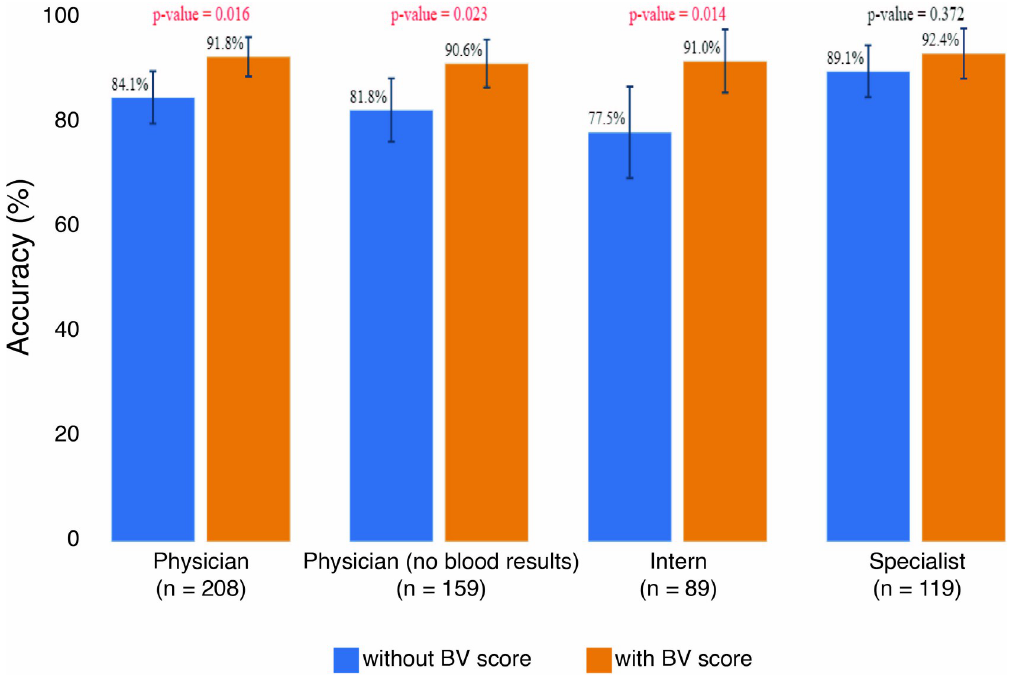
Fig 3. Diagnostic accuracy rate of etiological suspicion at the time of patient examination. The calculations and assumptions are explained in Methods. Error bars indicate 95% confidence intervals. P-values were computed using a one- sided Fisher-exact test; significant p-values appear in red text. Data are shown for the primary (reference standard bacterial/ viral) cohort that had completed questionnaires; n = 208.